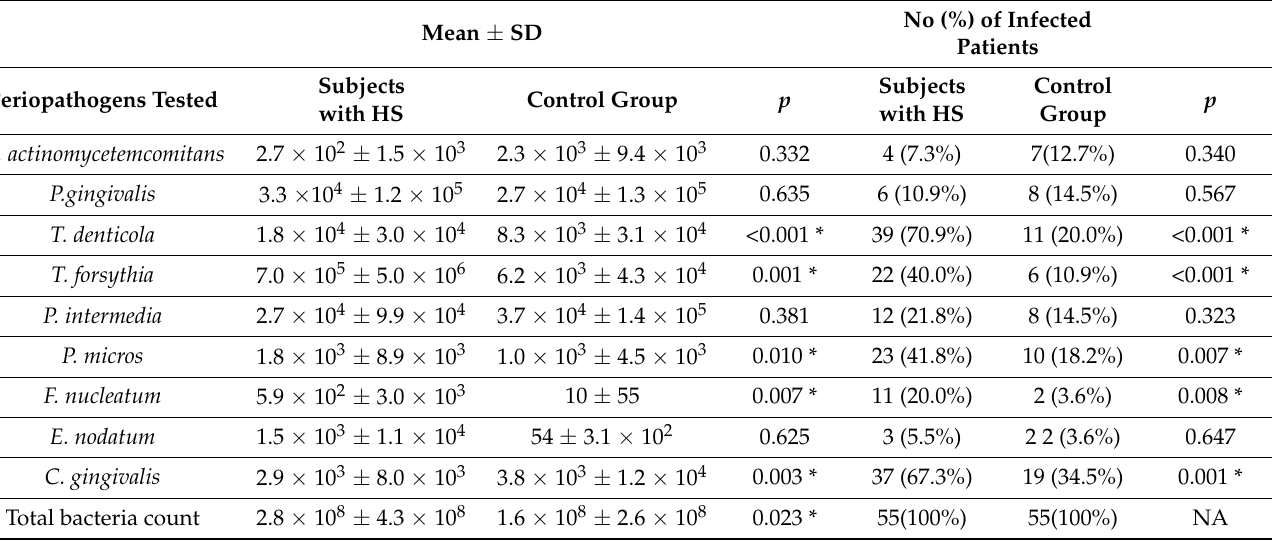
Table 3. Comparison of the copy number of pathogens collected from gingival sulci and the percent- age of patients with particular bacteria in the HS group and the control group.